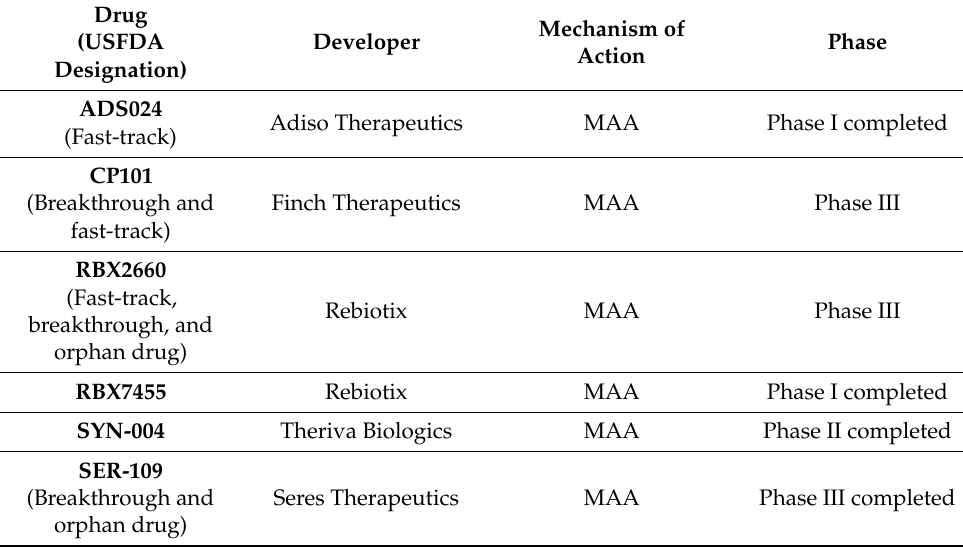
Table 2. Summary of the novel treatments for